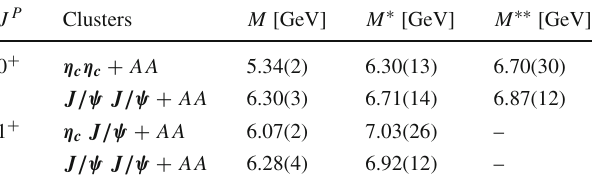
Table3 Numericalvaluesfortheground statesandtheexcitationspec- tra (excitation levels denoted by stars, ∗ ) of different all-charm four- quark candidates using different clusters. Bold-written clusters are the dominant ones. A stands for an axialvector (anti-)diquark